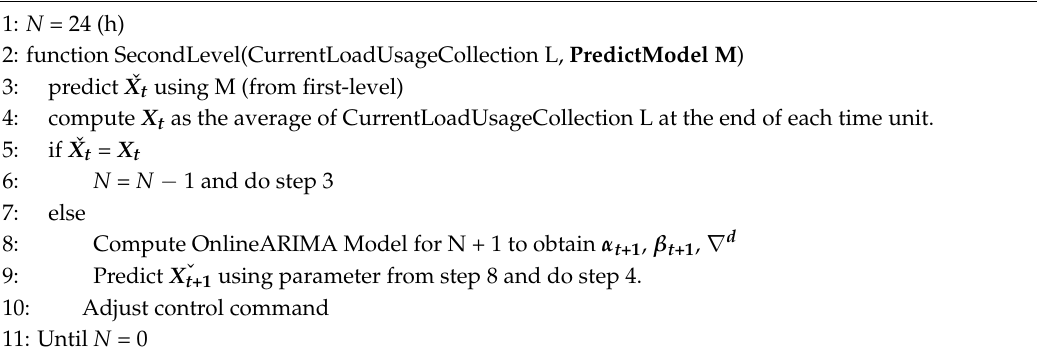
Algorithm 2. One-hour-ahead model prediction for the second